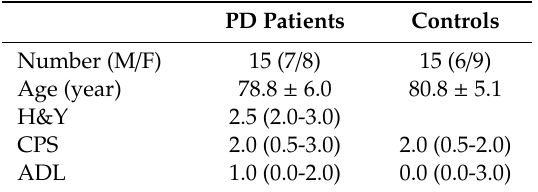
Table 1. Characteristics of subjects included in the